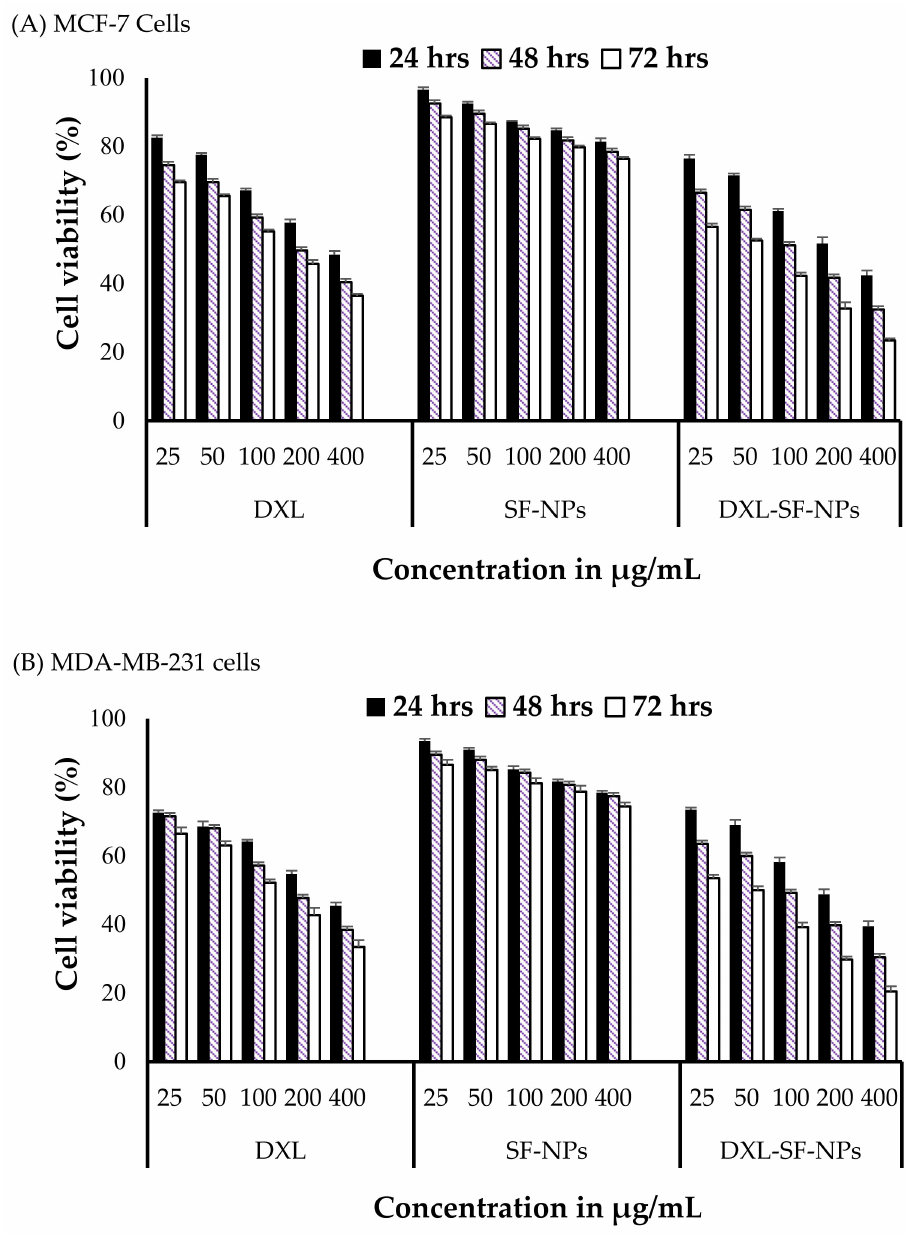
Figure 4. In vitro cytotoxicity of DXL-loaded SF-NPs against breast cancer cell lines. ( A ) MCF-7 and ( B ) MDAMB-231 cells were incubated with different concentrations (25–400 µ g/mL) of free DXL, SF-NPs, or DXL-loaded SF-NPs for different incubation times (24, 48, and 72 h), and cell viability was then assessed by MTT assay. Data represent mean ±